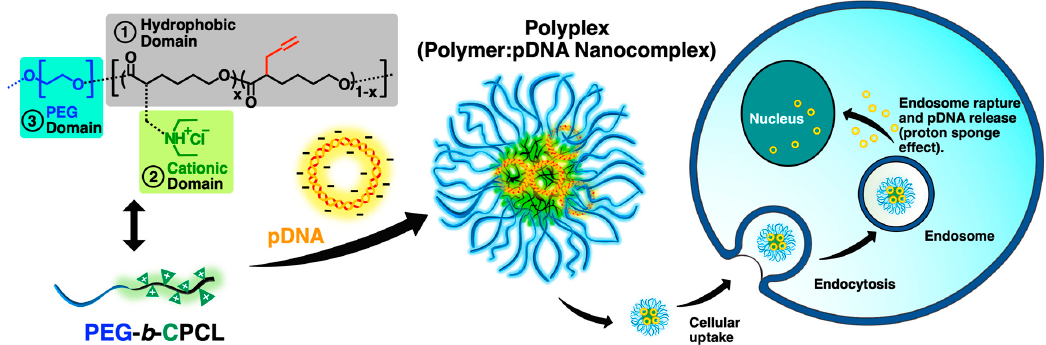
Figure 1. Non-viral pDNA delivery using PEG- b -CPCL.